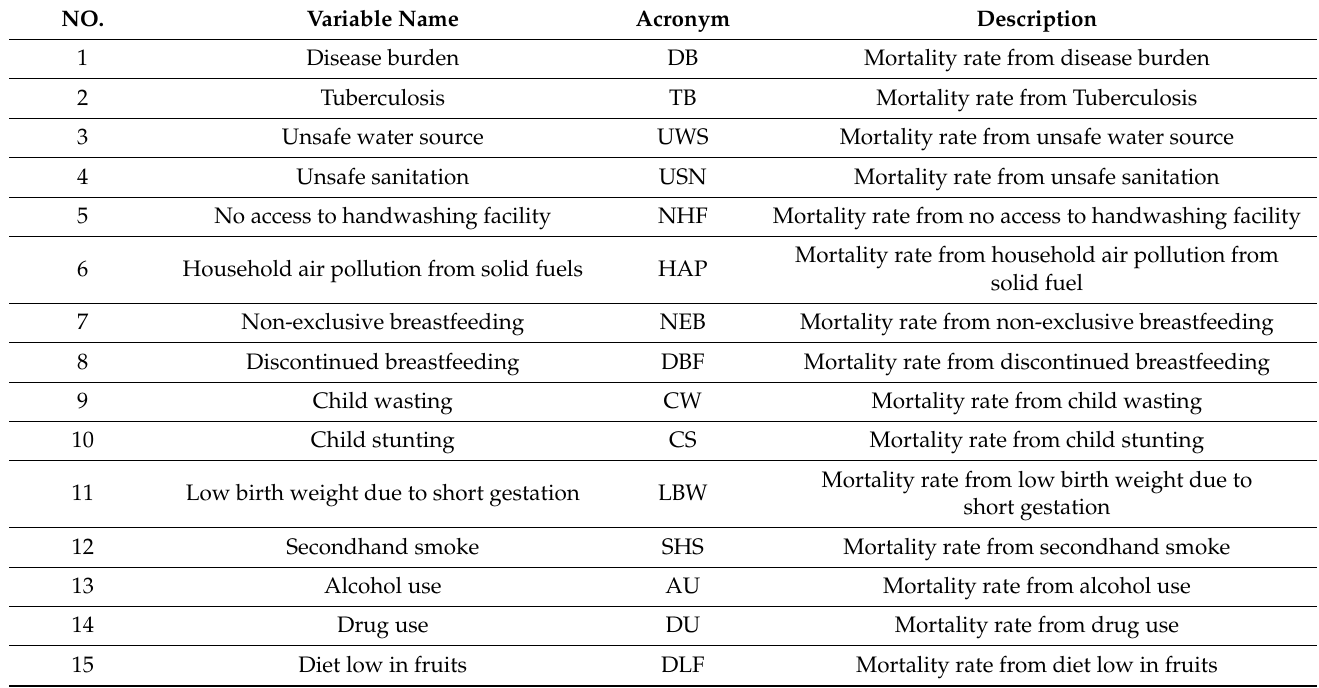
Table 1. List of risk factors of a country used as independent variables in the